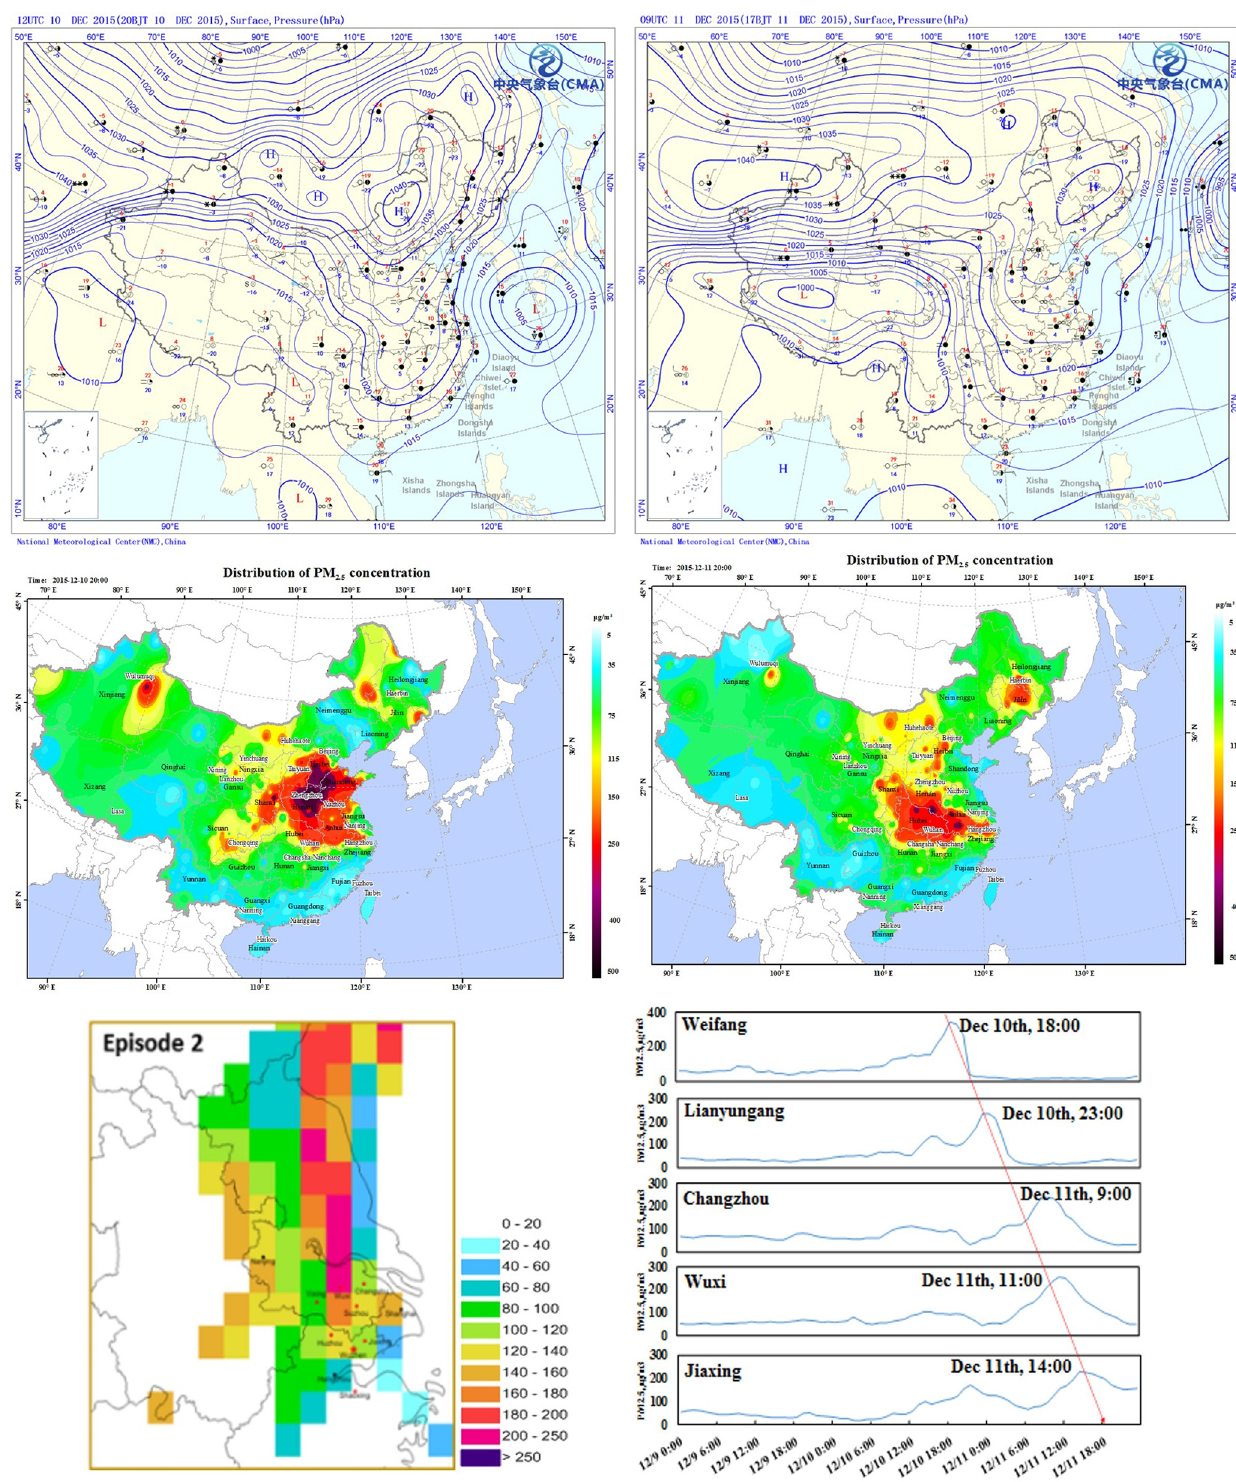
Figure 5. Analysis of (a) the large-scale weather patterns, (b) distribution of PM 2 . 5 concentrations, (c) potential regional sources, and (d) observed PM 2 . 5 time series for select sites during 10 to 11 December